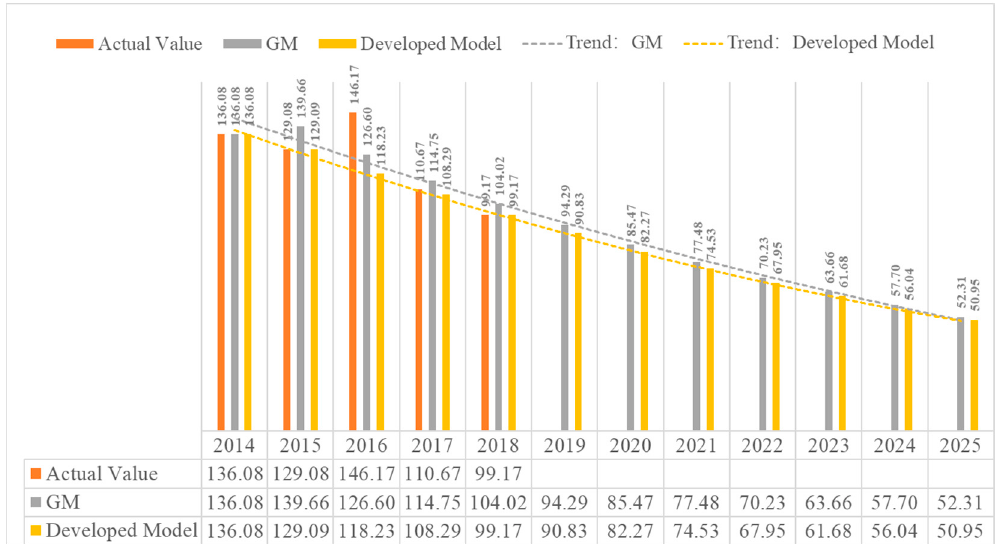
Figure 2. The changing trend of PM 10 from 2014 to